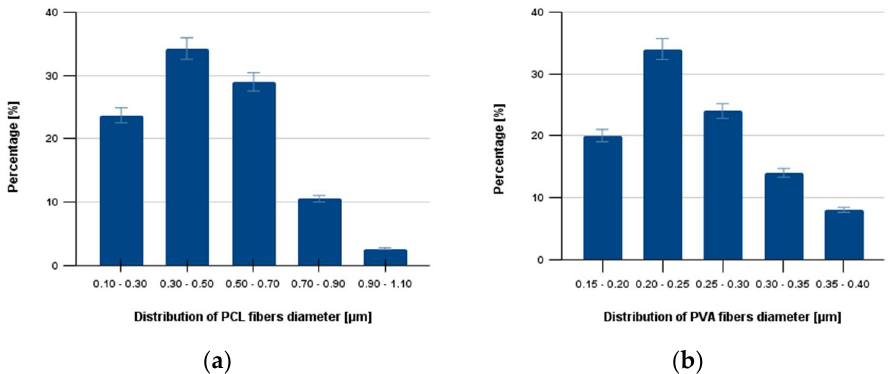
Figure 4. The average diameter of the PCL and PVA nanofibers. Subfigure ( a ) shows the average distribution of PCL nanofibers, and subfigure ( b ) describes the average distribution of PVS nano- fibers.